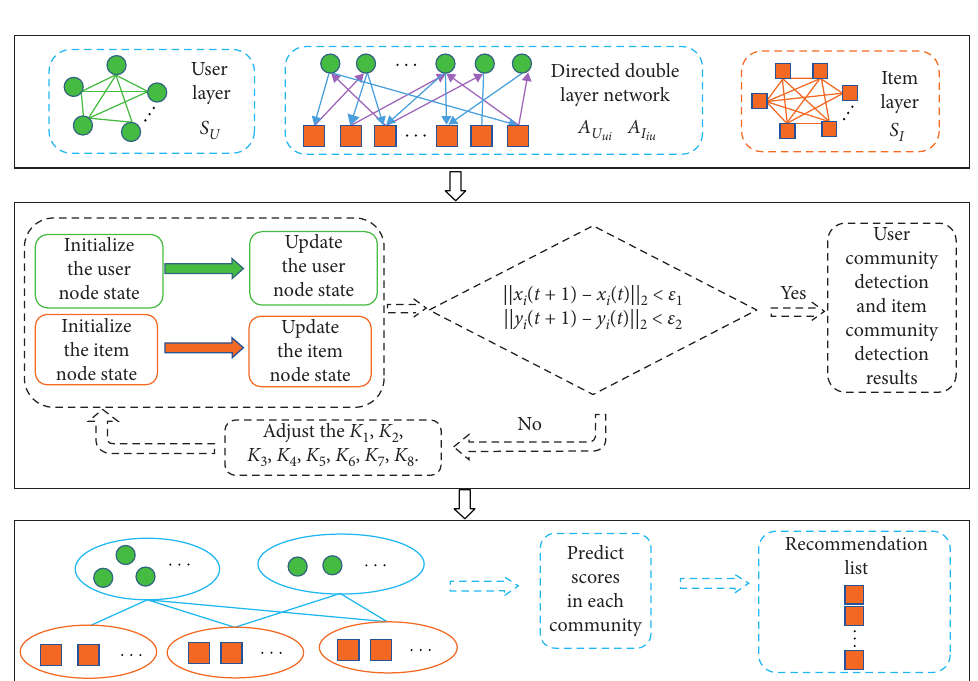
Figure 2: Flowchart of DN −